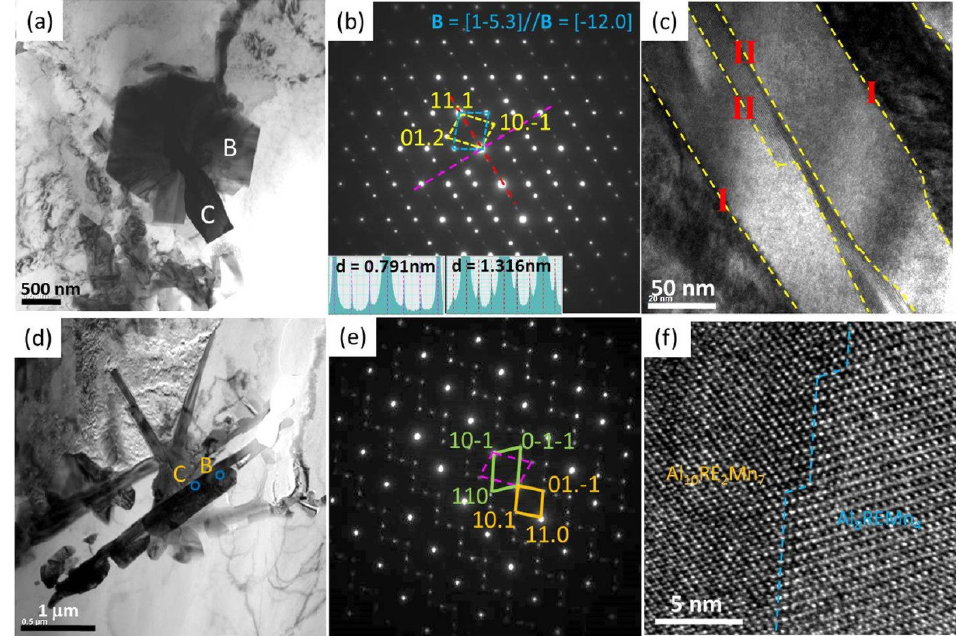
Figure 3. ( a , c , d ) BF-TEM images; ( b , e ) SAED patterns; ( f ) high-resolution TEM (HRTEM) images of Al-Mn-RE phases in AE44 alloys [110,111].